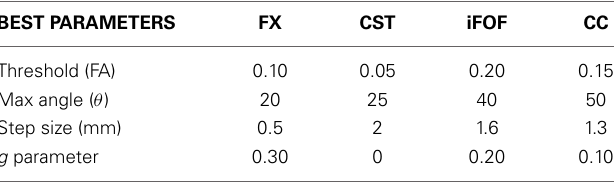
Table 6 | Best tractography parameters used for the reconstruction of the FX, CST, iFOF, and